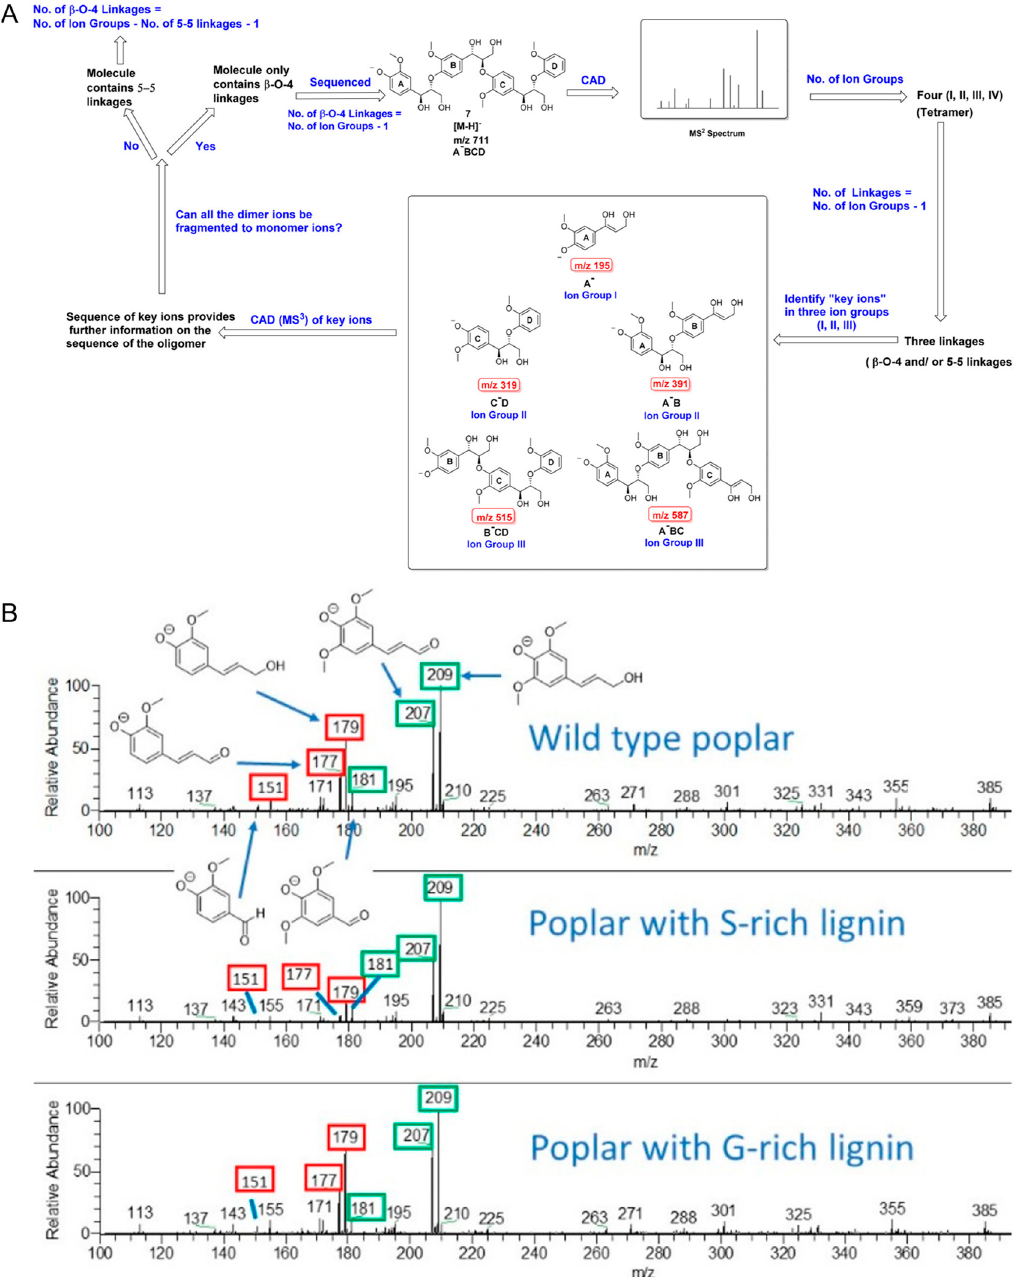
Figure 10. ( A ) A workflow for sequencing lignin oligomers with different linkages using multi-stage CID; key ion groups are shown in the black box [163]. ( B ) CID high-resolution mass spectra for three types of natural lignin samples. Fragment ions related to G-lignin are labelled in red boxes, and fragment ions related to S-lignin are labelled in green boxes. The ratio of the peak abundances of these fragment ions are used for the determination of G- and S-lignin content in the wild-type lignin samples [165]. Adjusted and reprinted with permissions from the American Chemical Society.